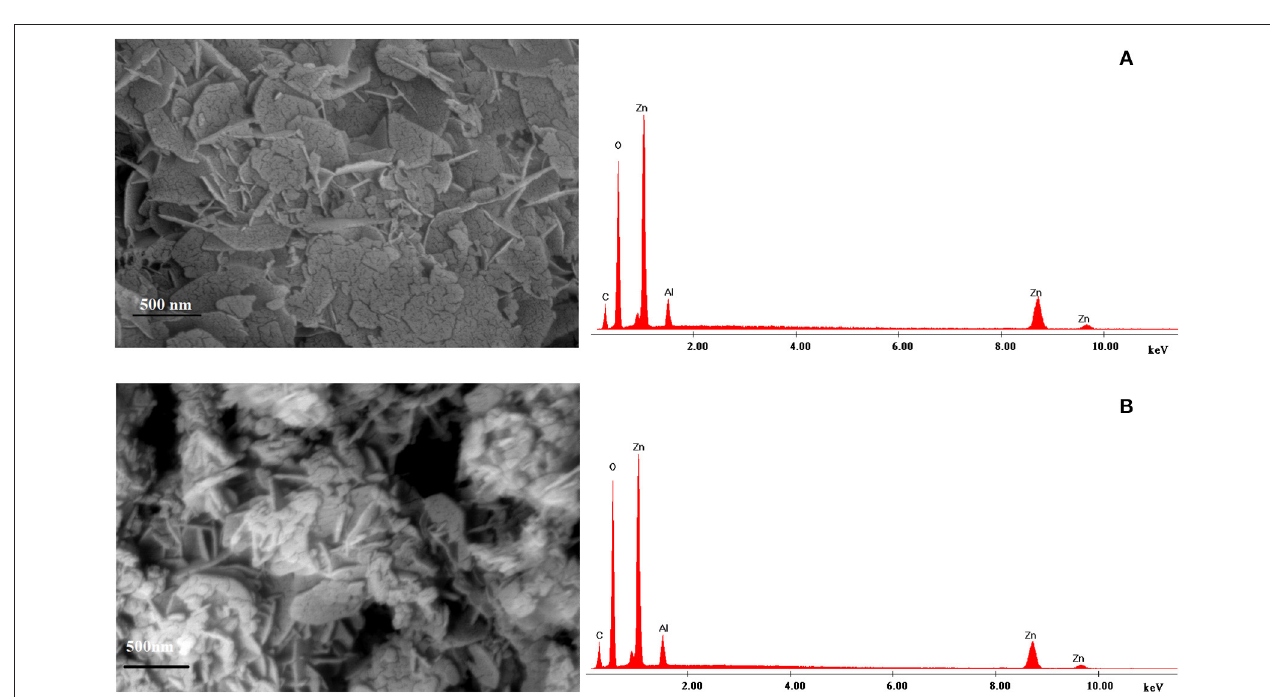
FIGURE 2 | SEM images and EDX spectra for (A) LDH-W and (B) LDH-R.